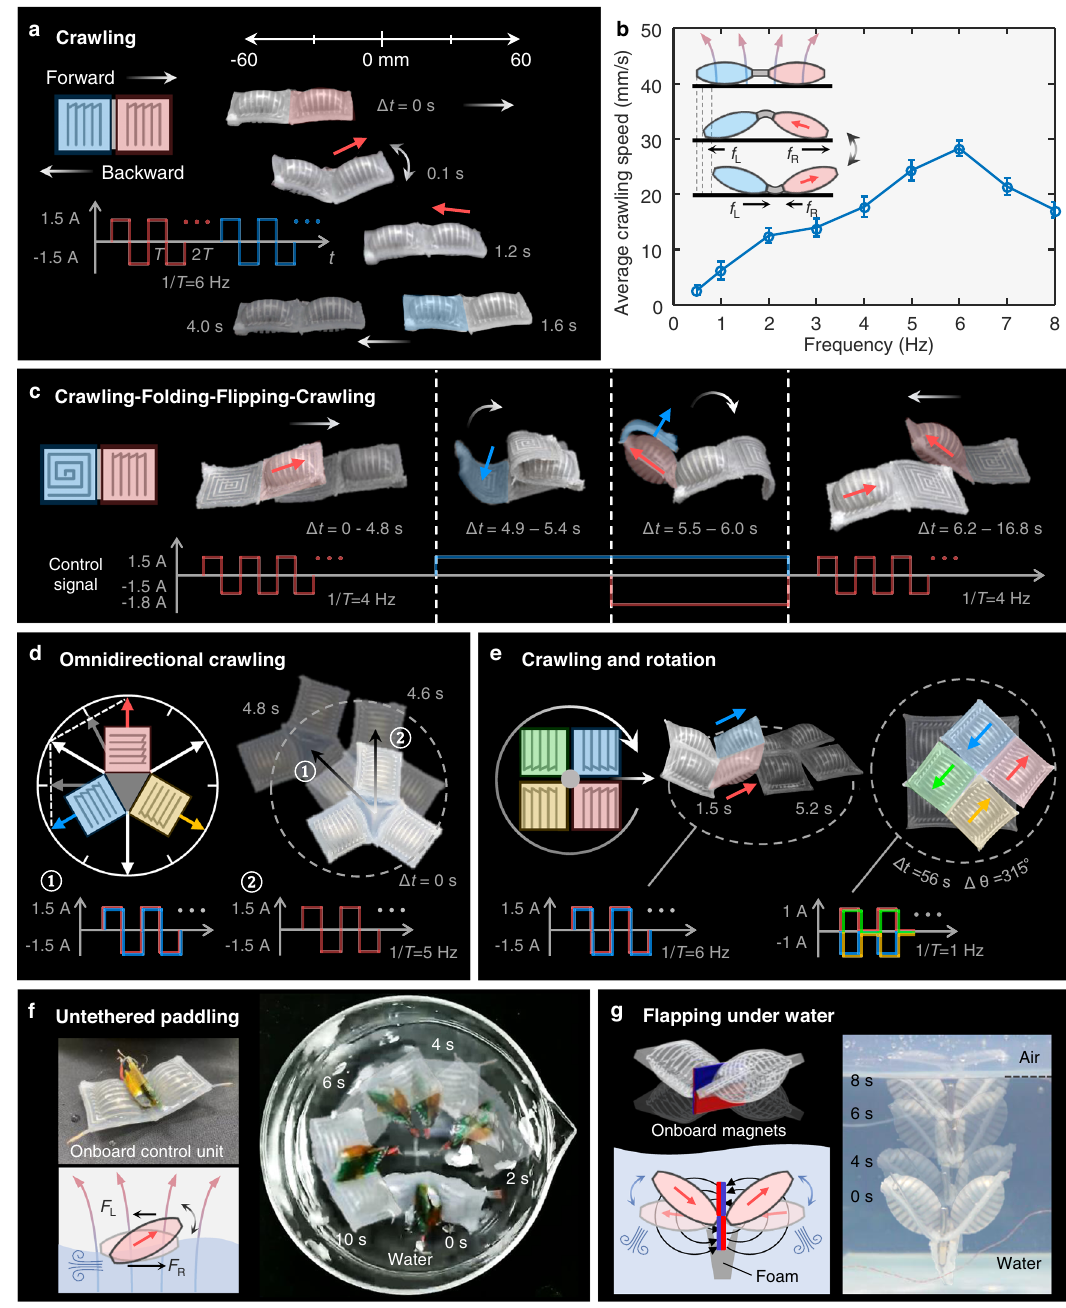
Fig. 6 | Multimodal locomotion of SESRs by self-vectoring control. a Reciprocating crawling of an H-H robot with aligned EVs. Activating different module by a periodic bipolar square-wave signal, the robot crawls towards the correspondingdirectionlikeacaterpillar. b Thecrawlingmechanismandthespeed curve of the H-H robot. Error bars represent standard deviation. c Reciprocating crawling-folding-crawling motion of an H-V robot. The direction was changed by shape morphing and fl ipping movement. d Omnidirectional crawling of an H||